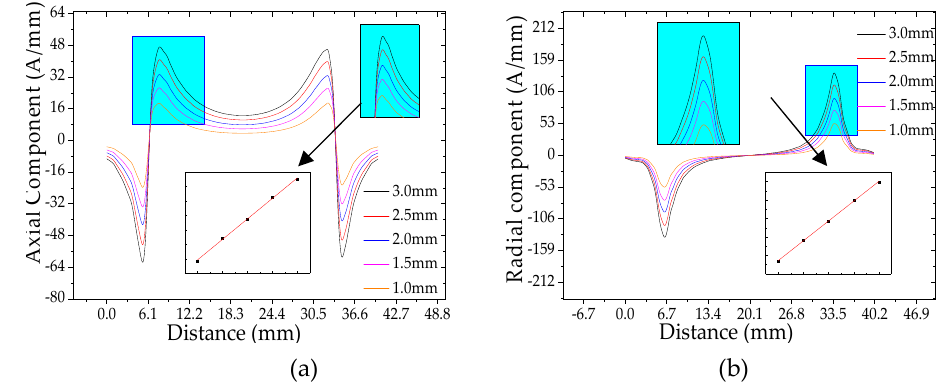
Figure 8. The weak magnetic signal of pipeline crack with different crack depths: ( a ) axial component and ( b ) radial component. And the axial maximum and the radial peak of the weak magnetic signal at the crack are extracted, and the relationship between the signal and the crack depth is shown in the figure.